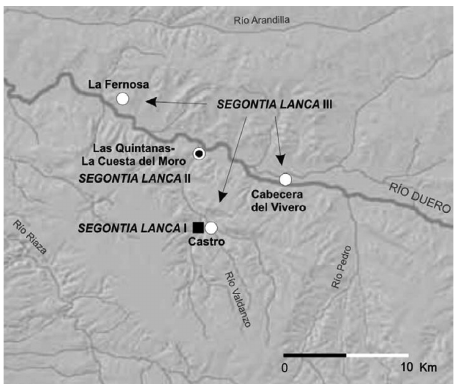
Figure 2: The locations of Segontia Lanca (after Martínez Caballero 2010, fig.